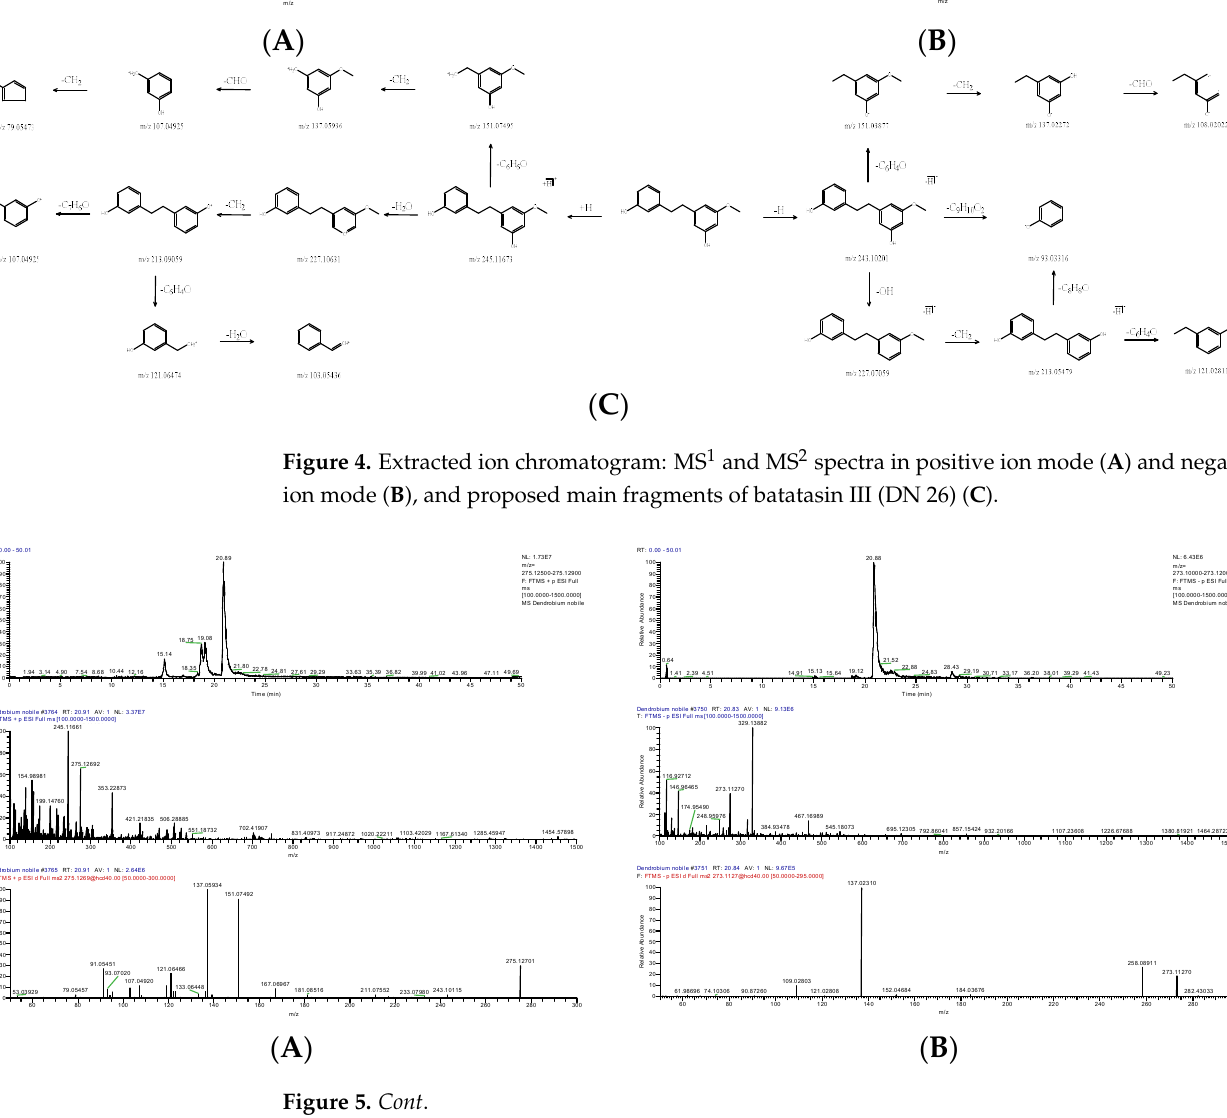
Figure 5. Extracted ion chromatogram: MS 1 and MS 2 spectra in positive ion mode ( A ) and negative ion mode ( B ), and proposed main fragments of gigantol (DN 29) ( C ).